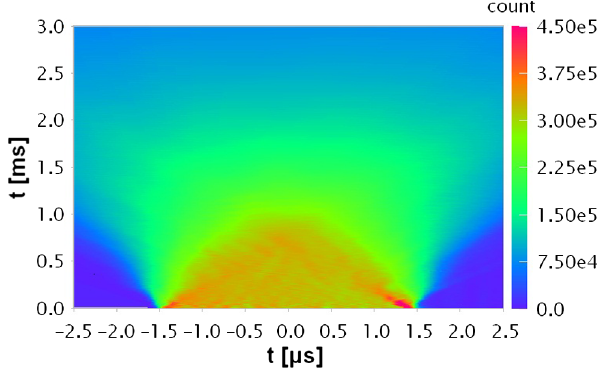
FIG. 35. Simulation result for the mountain view correspond- ing to a 100 (cid:1) A beam